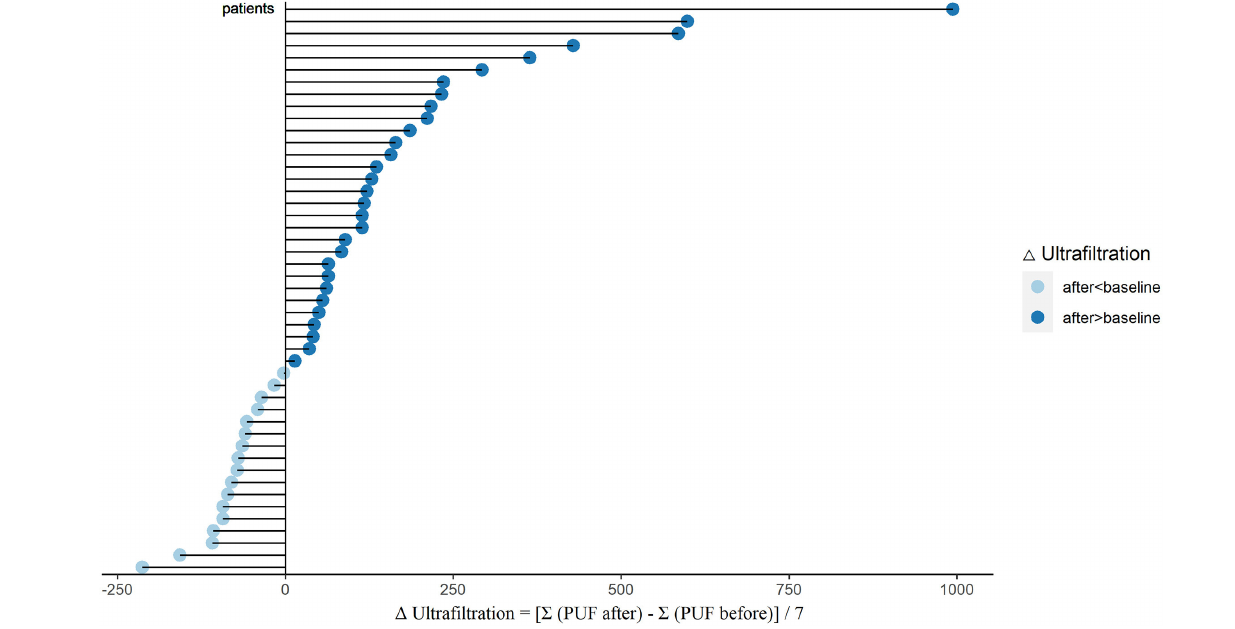
FIGURE 1 | Changes of PUF ( 1 Ultrafiltration) after sacubitril-valsartan initiating in PD patients. Daily PUF was collected within 7 days before (PUF before) and after (PUF after) sacubitril-valsartan treatment. 1 Ultrafiltration = [ Σ (PUF after) – Σ (PUF before)]/7. After treated with sacubitril-valsartan, 30 patients had obvious increase of PUF (dark blue color), and 17 patients had slight decrease (light blue color). PUF, peritoneal ultrafiltration; PD, peritoneal dialysis.